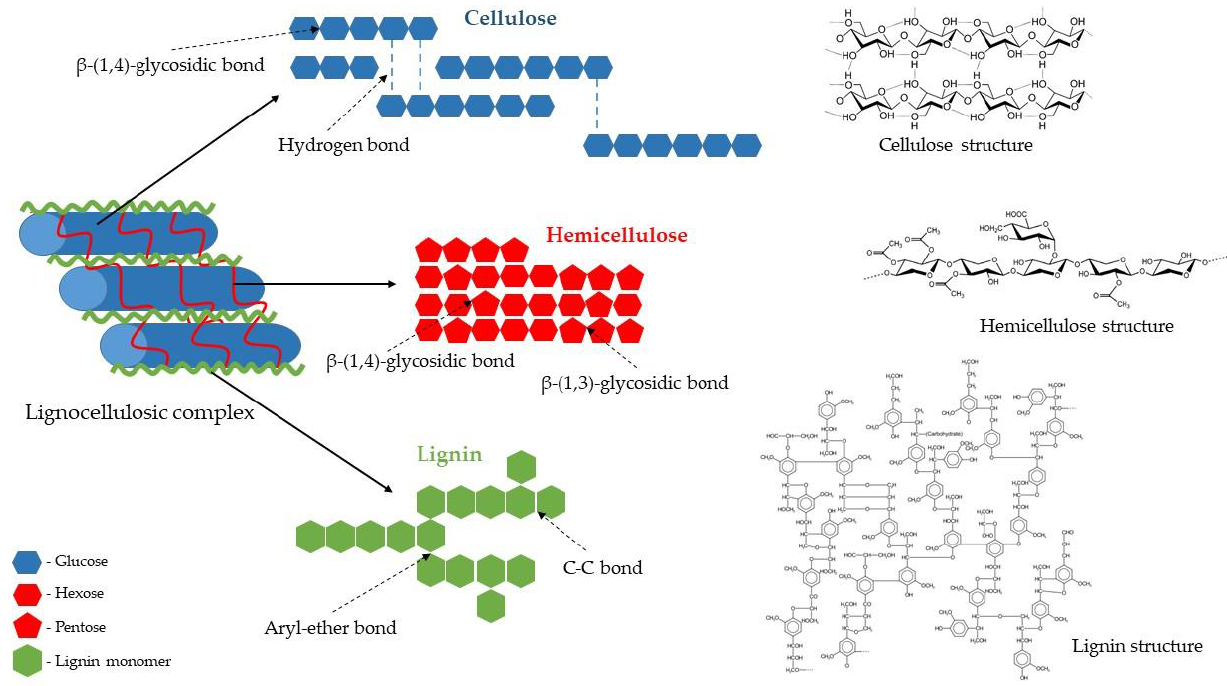
Figure 5. A schematic structure of the lignocellulosic complex (based on [35,36]).